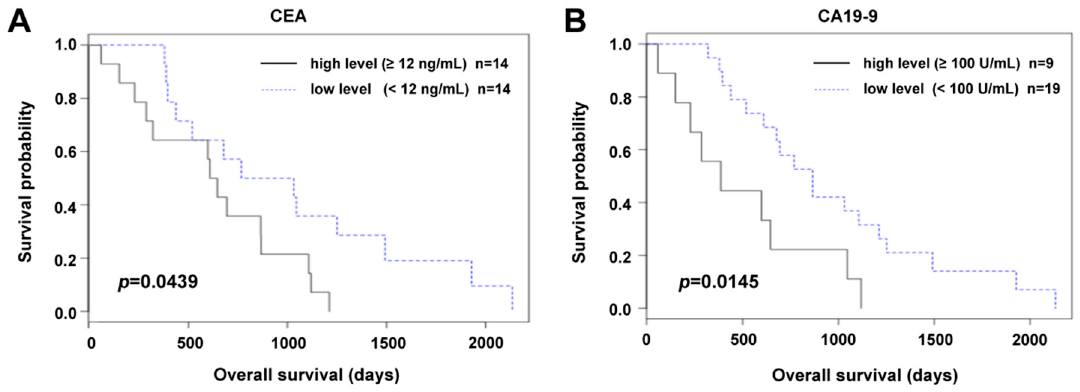
Figure 4. Relation of CEA ( A ) and CA19-9 ( B ) preoperative plasma levels to overall survival (OS) in a group of patients who underwent palliative surgery (Kaplan–Meier curves).